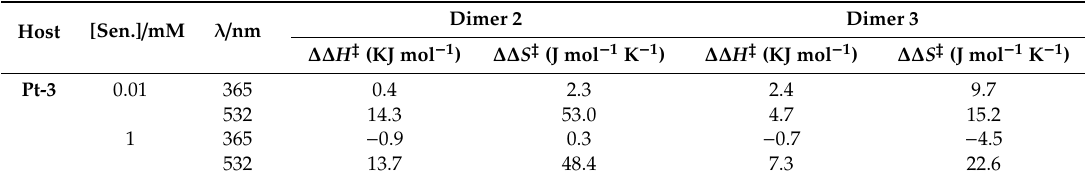
Table 5. Di ff erential activation parameters determined from the temperature dependence of the ee of cyclodimers 2 and 3 in the photocyclodimerization of AC catalyzed by